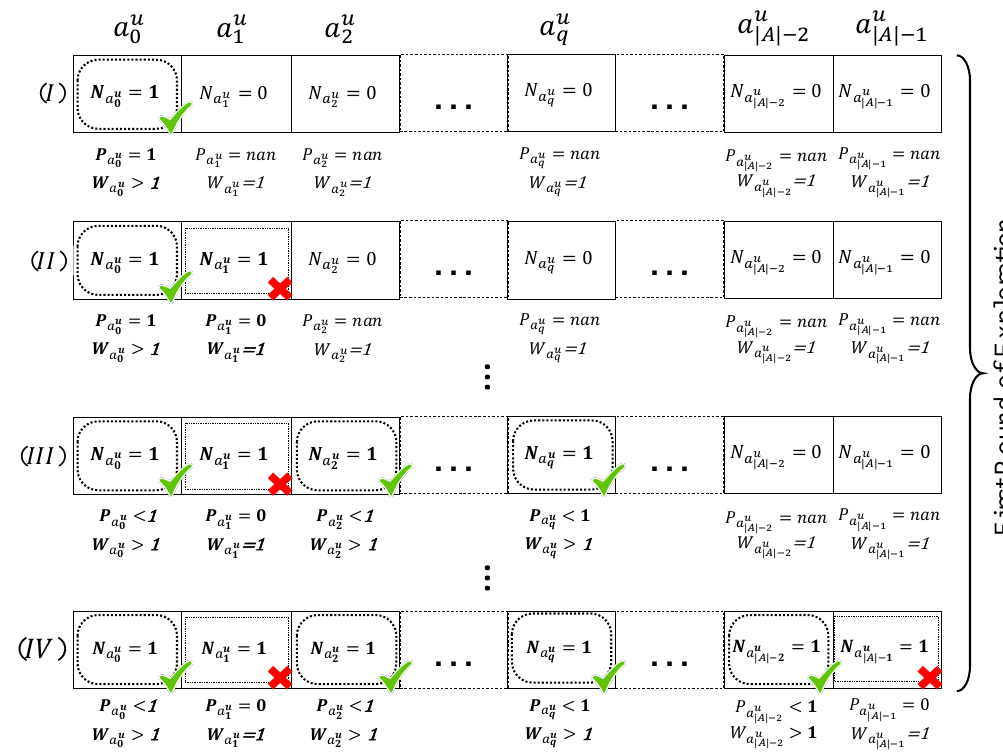
Figure 5. Possible first round of the LP-MAB exploration phase for the u th ED.